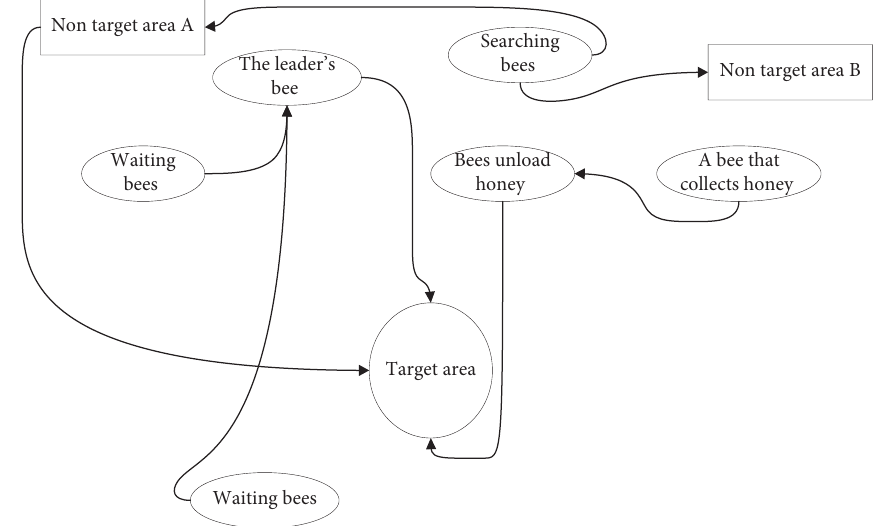
Figure 1: The principle of the artificial bee colony